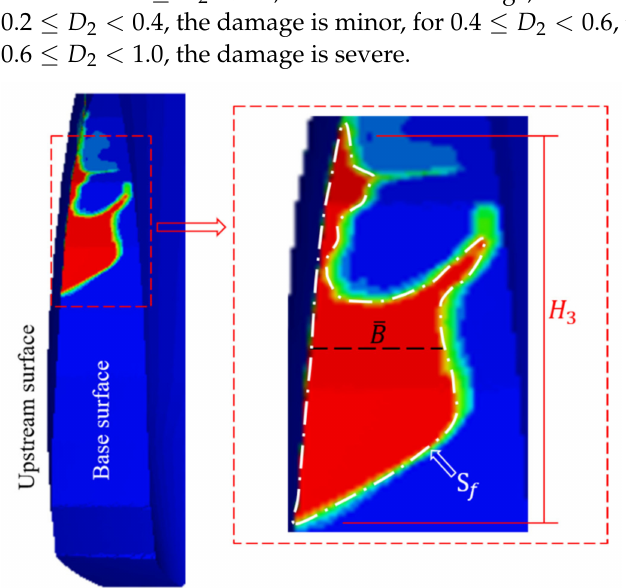
Figure 5. Parameters for local damage to the abutment.